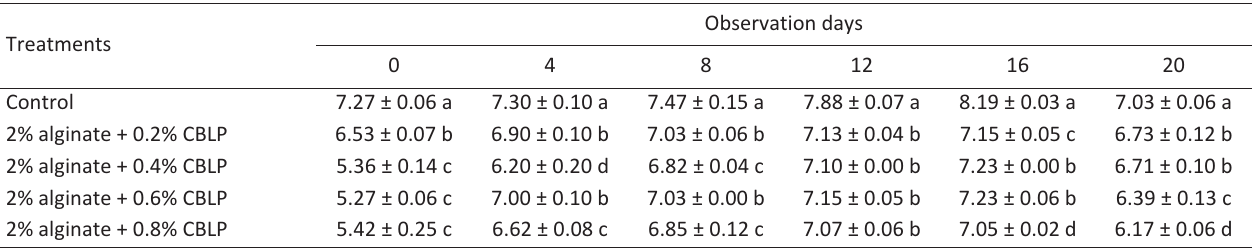
Results followed by the same letter(s) imply that there is no significant difference between results according to the Duncan multiple range